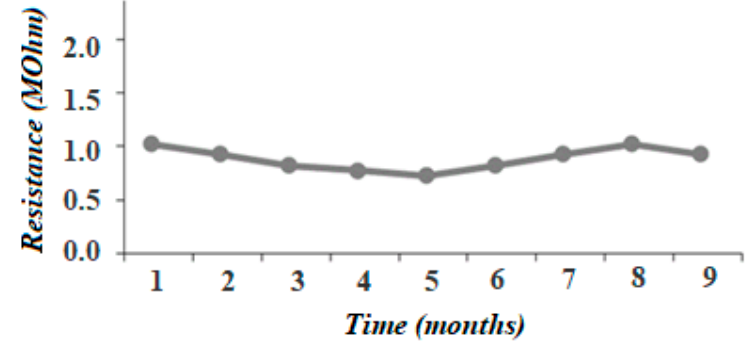
Figure 13. Dependence of the surface resistance of thin film sensors on time.